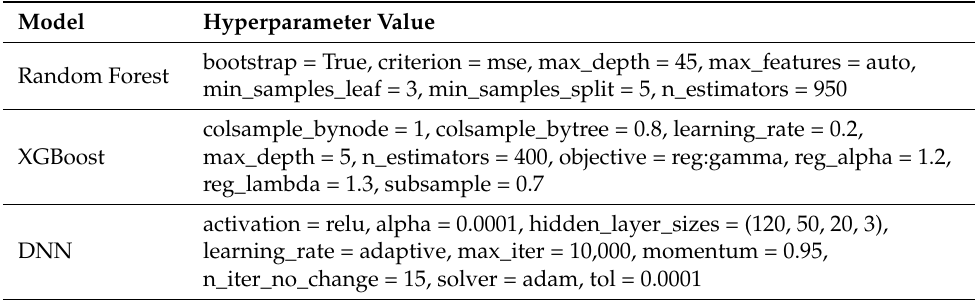
Table 4. Optimized hyperparameters for the different ML-based regression models trained, validated and tested on SMOTE-set